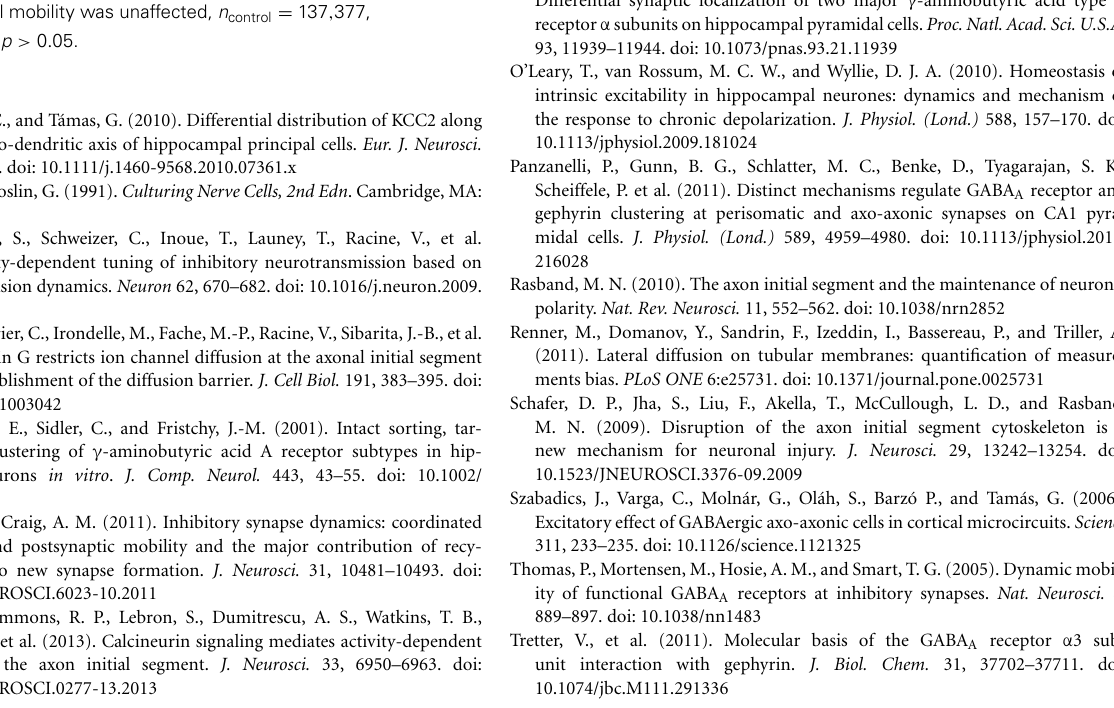
staining (AIS); right: mGFP expression, with AIS and sample dendrite labeled. (B) Zoomed regions of AIS and dendrite shown boxed in (A) . (C) Process diameter of AIS and dendrites is not significantly different. AIS: